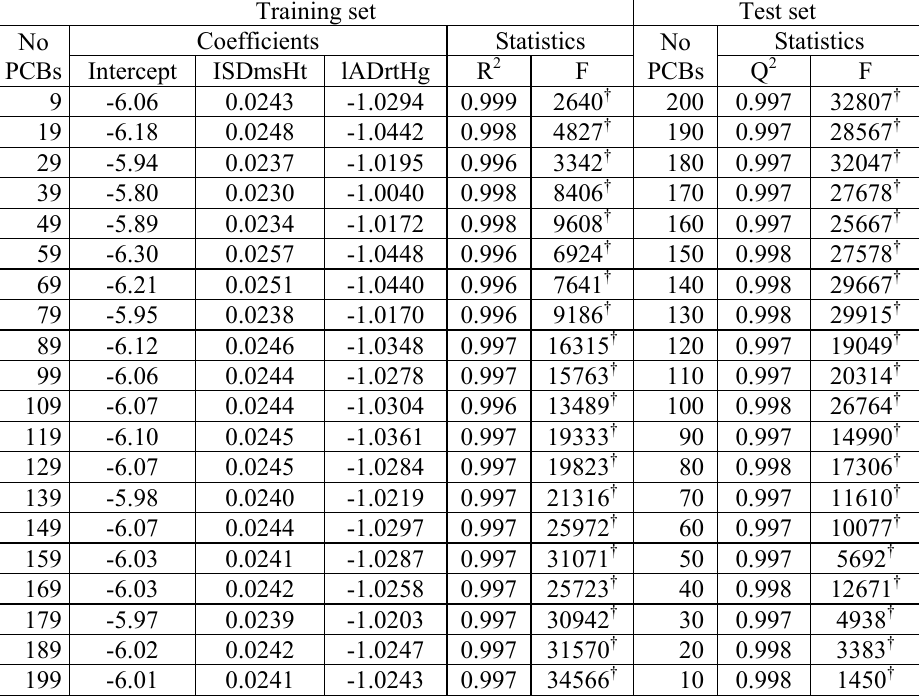
Table 2. Training vs Test Experiments: